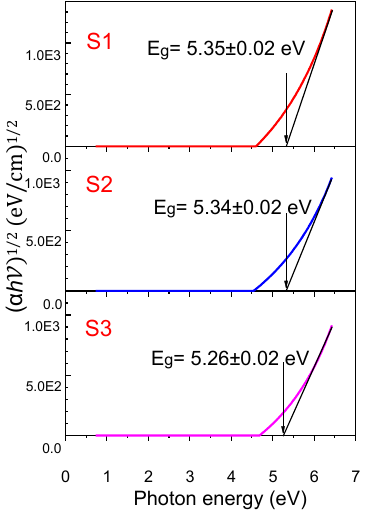
Figure 11. ( α h ν ) 1/2 versus photon energy plots of the HfO 2 films.